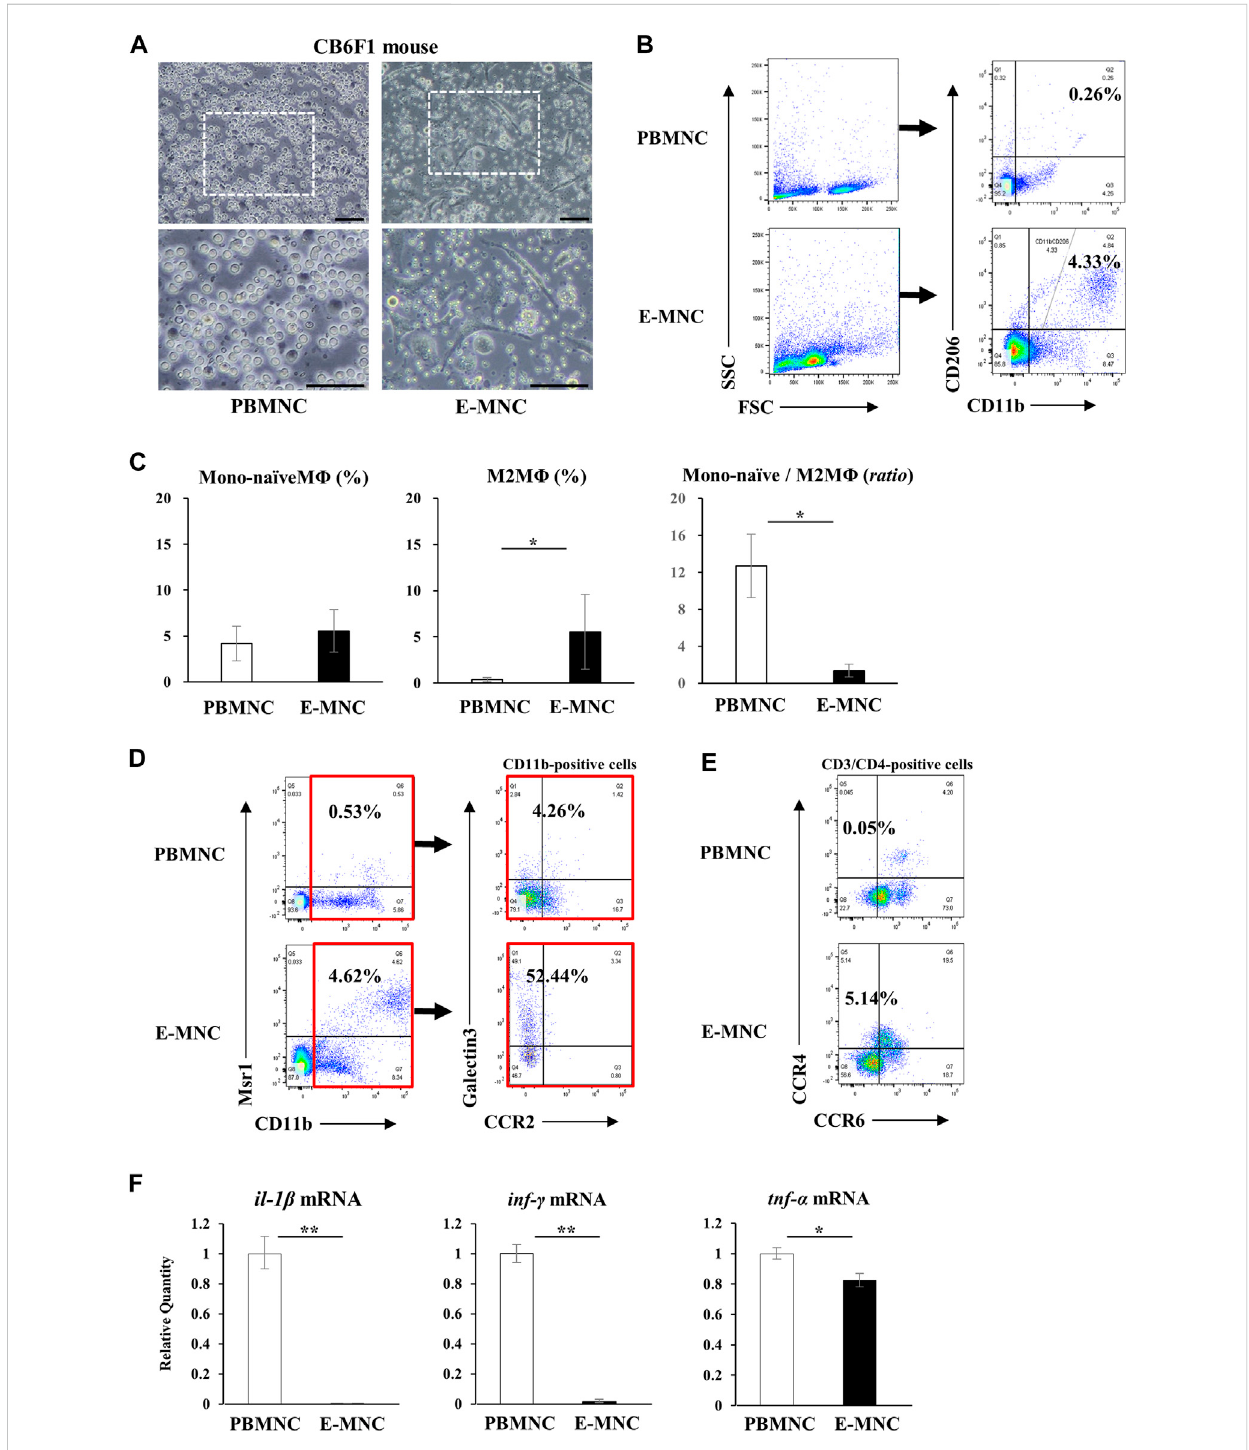
FIGURE 3 Characteristics of mouse E-MNCs. (A) Phase-contrast imaging of CB6F1 mouse PBMNCs (at day 0) and E-MNCs (at day 7). White boxed areas in the upper images (scale bar, 100 µm) were magni fi ed in the lower images (scale bar, 100 µm). (B) Flow cytometric analysis of FSC/SSC gated cells, CD11b + / CD206 − (Mono-naïve) and CD11b + /CD206 + (M2) macrophages, among PBMNCs (at day 0) and E-MNCs (at day 7). (C) Percentages of Mono-naïve (CD11b + /CD206 − ) and M2 (CD11b + /CD206 + ) macrophage fractions and their ratios (Mono-naïve/M2) among PBMNCs and E-MNCs (* p < 0.05). (D) Flow cytometric analysis of CD11b + /Msr1 + (M2c; left panels) macrophages and CCR2/galectin3 + (right panels) CD11b-positive macrophages among PBMNCs (at day 0) and E-MNCs (at day 7). (E) Flow cytometric analysis of CCR6 − /CCR4 + Th2 cells in CD3 + /CD4 + gated cells of PBMNCs (at day 0) and E-MNCs (at day 7). (F) Expression of pro-in fl ammatory mRNAs ( il-1 β , ifn- γ , and tnf- α ) in PBMNCs (at day 0) and E-MNCs (at day 7) (* p < 0.05, ** p < 0.01). For statistical analysis, the Student ’ s t-test was performed to determine the signi fi cance of differences among PBMNCs and